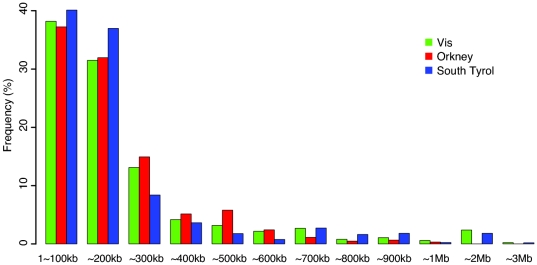
Distribution of CNV lengths in the three genetic isolate populations.